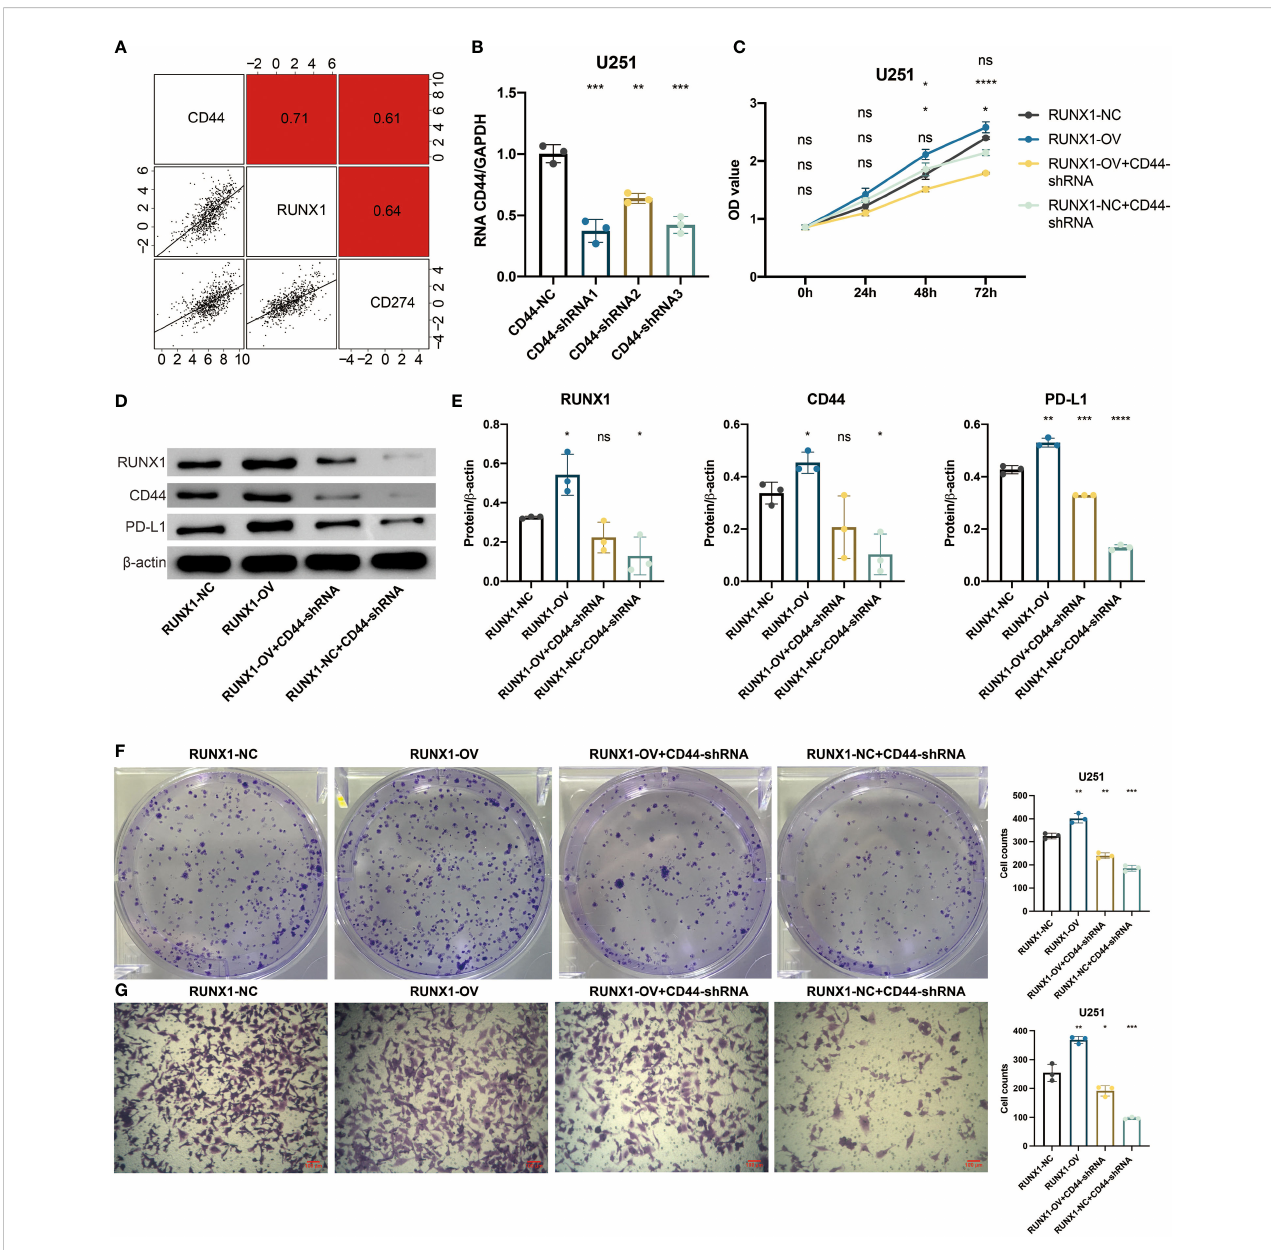
FIGURE 6 RUNX1/CD44 axis mediates proliferation and migration of glioma. (A) Correlation between CD44 and RUNX1, PD-L1 in the TCGA dataset. (B) qPCR assay for CD44 in shRNA-transfected U251 cells. (C) CCK8 assay for four groups of U251 cells. (D) Western blotting assay for RUNX1, CD44, and PD-L1 in shRNA-transfected U251 cells. (E) Statistical analysis of western blotting assay for RUNX1, CD44, and PD-L1. (F) Clone formation assay for four groups of U251 cells. (G) Transwell assay for four groups of U251 cells. NS, Not Statistically Signi fi cant; *, P< 0.05; **, P<0.01; ***, P<0.001; ****,